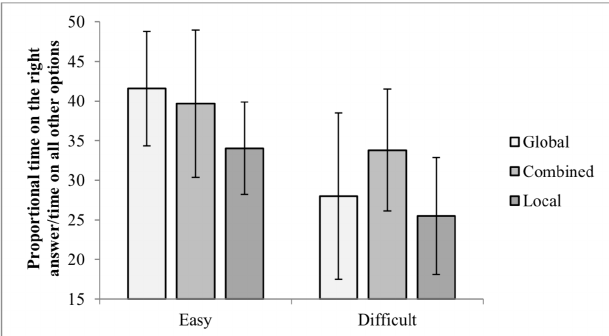
Figure 6. Proportional Time on the Right Answer/Time on all other Options on the CWMR Test.